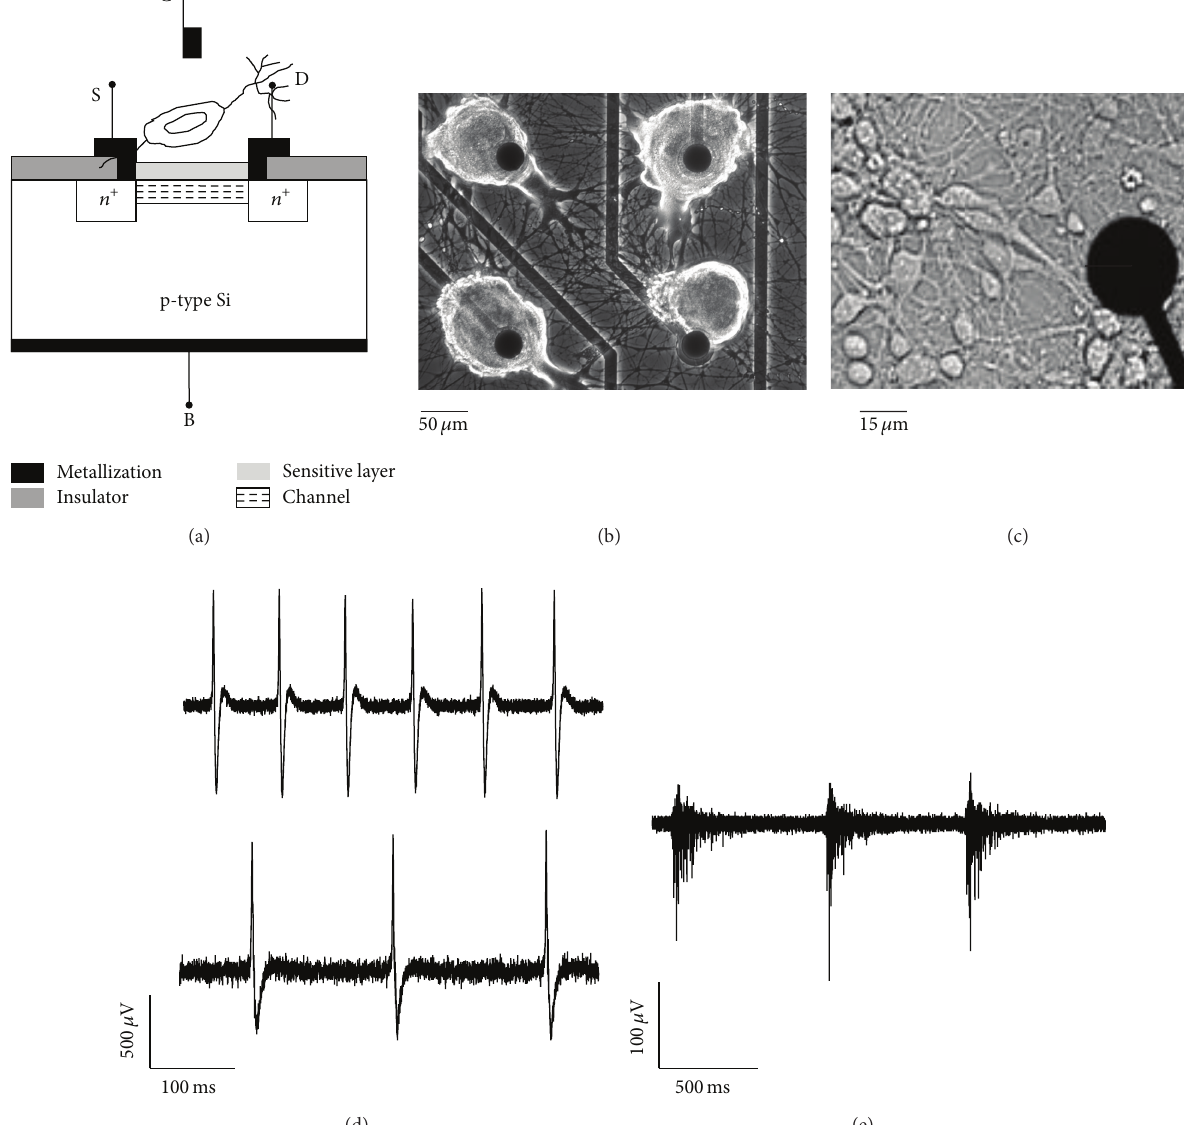
Figure 1: (a) Schematic representation of a field-effect transistor (FET). (b) Example of Helix neurons 24 hours after plating on MEA. Scale bar is 50 𝜇 m. (c) Cortical neurons after 24 days in vitro coupled to a MEA. Scale bar is 15 𝜇 m. (d) Extracellular action potentials recorded by a MEA relative to B2 (top) and C1 (bottom) Helix neurons. (e) Typical bursting activity of a cortical network recorded by a